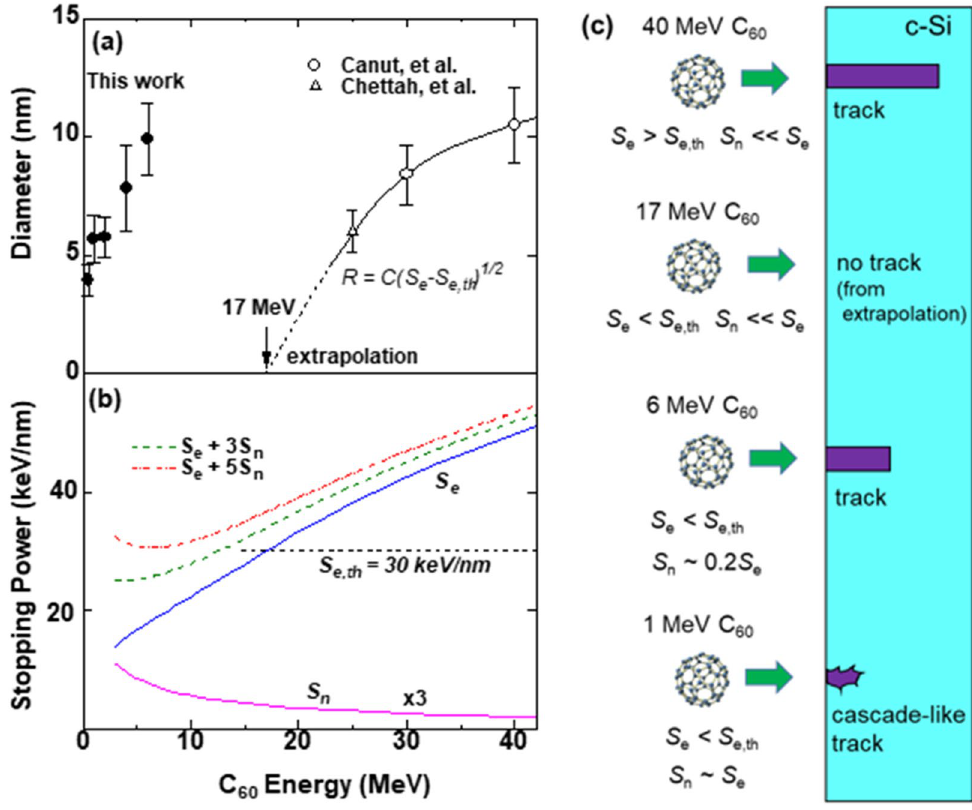
Figure 1. Ion energy dependence of ( a ) track diameter, ( b ) electronic ( S e ), nuclear ( S n ), and effective ( S eff ) stopping powers ( K = 3 and 5). In ( a ), the open circles, open triangle, and closed circles, respectively, denote data from Canut et al. 4 , Chettah et al. 7 , and the present study. S e,th denotes the threshold S e extrapolated from the data at 25 MeV and higher. ( c ) Schematic depiction of the ion energy dependence of track formation and its relationship to the stopping